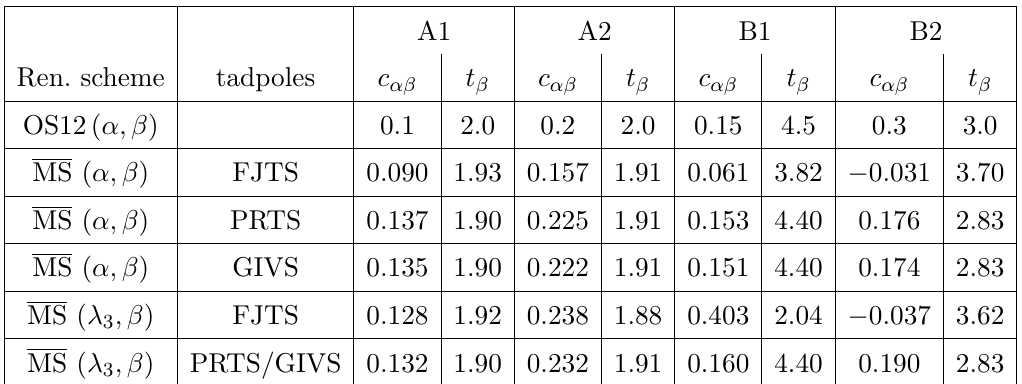
Table 5 . Conversion of parameters from the OS12 scheme as input scheme to the different MS renormalization schemes at the central scale µ 0 = ( M h + M H + M A PRTS, using the bare parameters for tan α and tan β in the